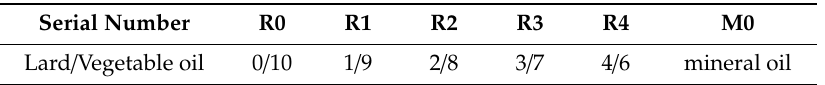
Table 2. Component of base oil.